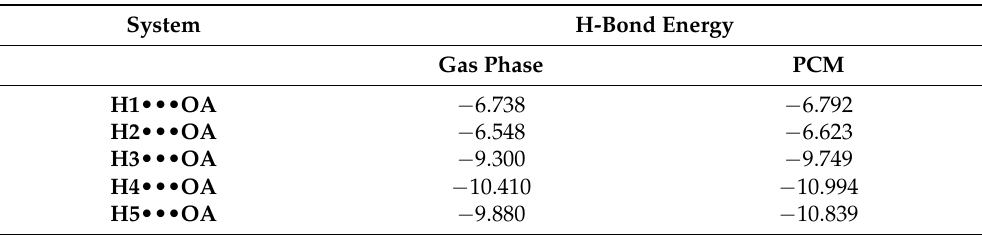
Table 2. Relative hydrogen bond energies as a difference of total energies of closed and open forms. Energy values given in